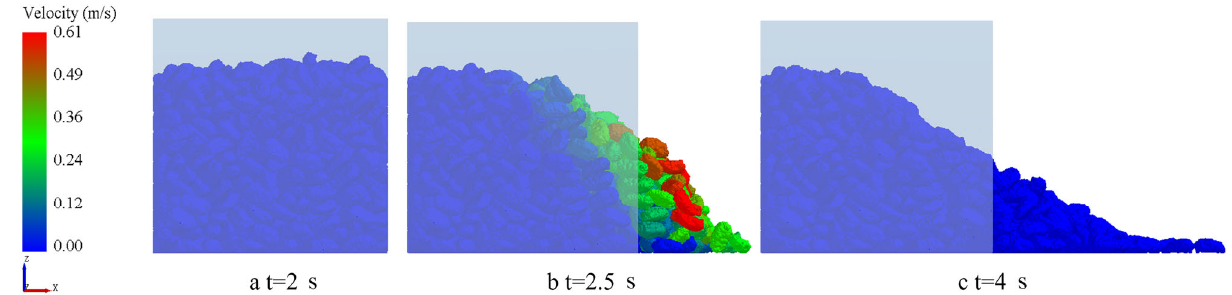
Figure 15. Snapshots of the simulation of the piling test of Jinong 2 seeds using the 170 ‐ sphere model.